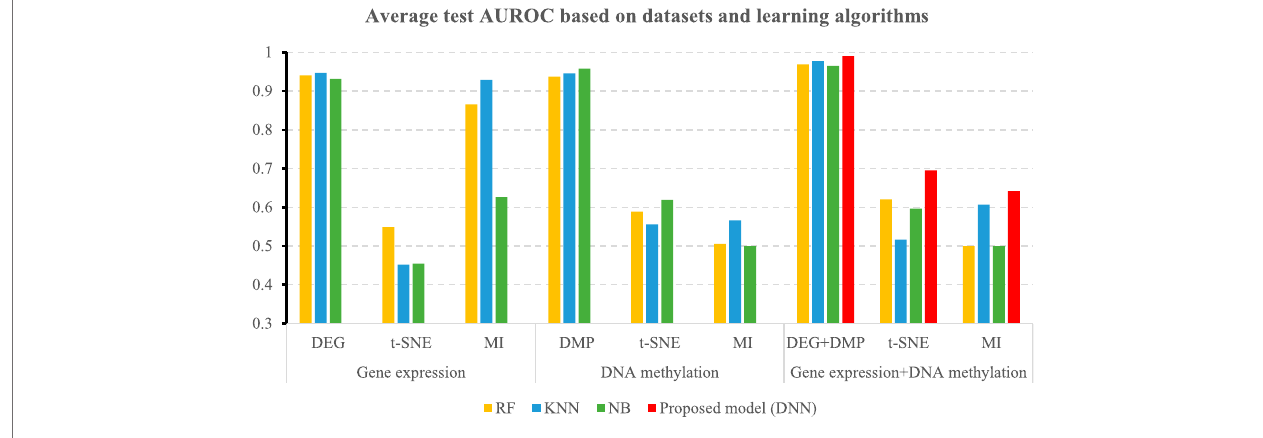
FIGURE 5 | Average AUROC of all comparisons and the proposed mode.